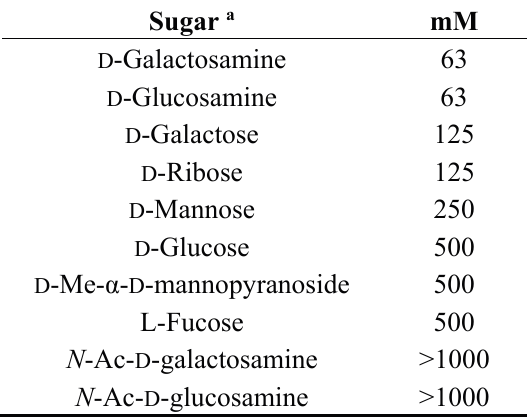
Table 3. Inhibition of hemagglutination activity of ATL by saccharides.